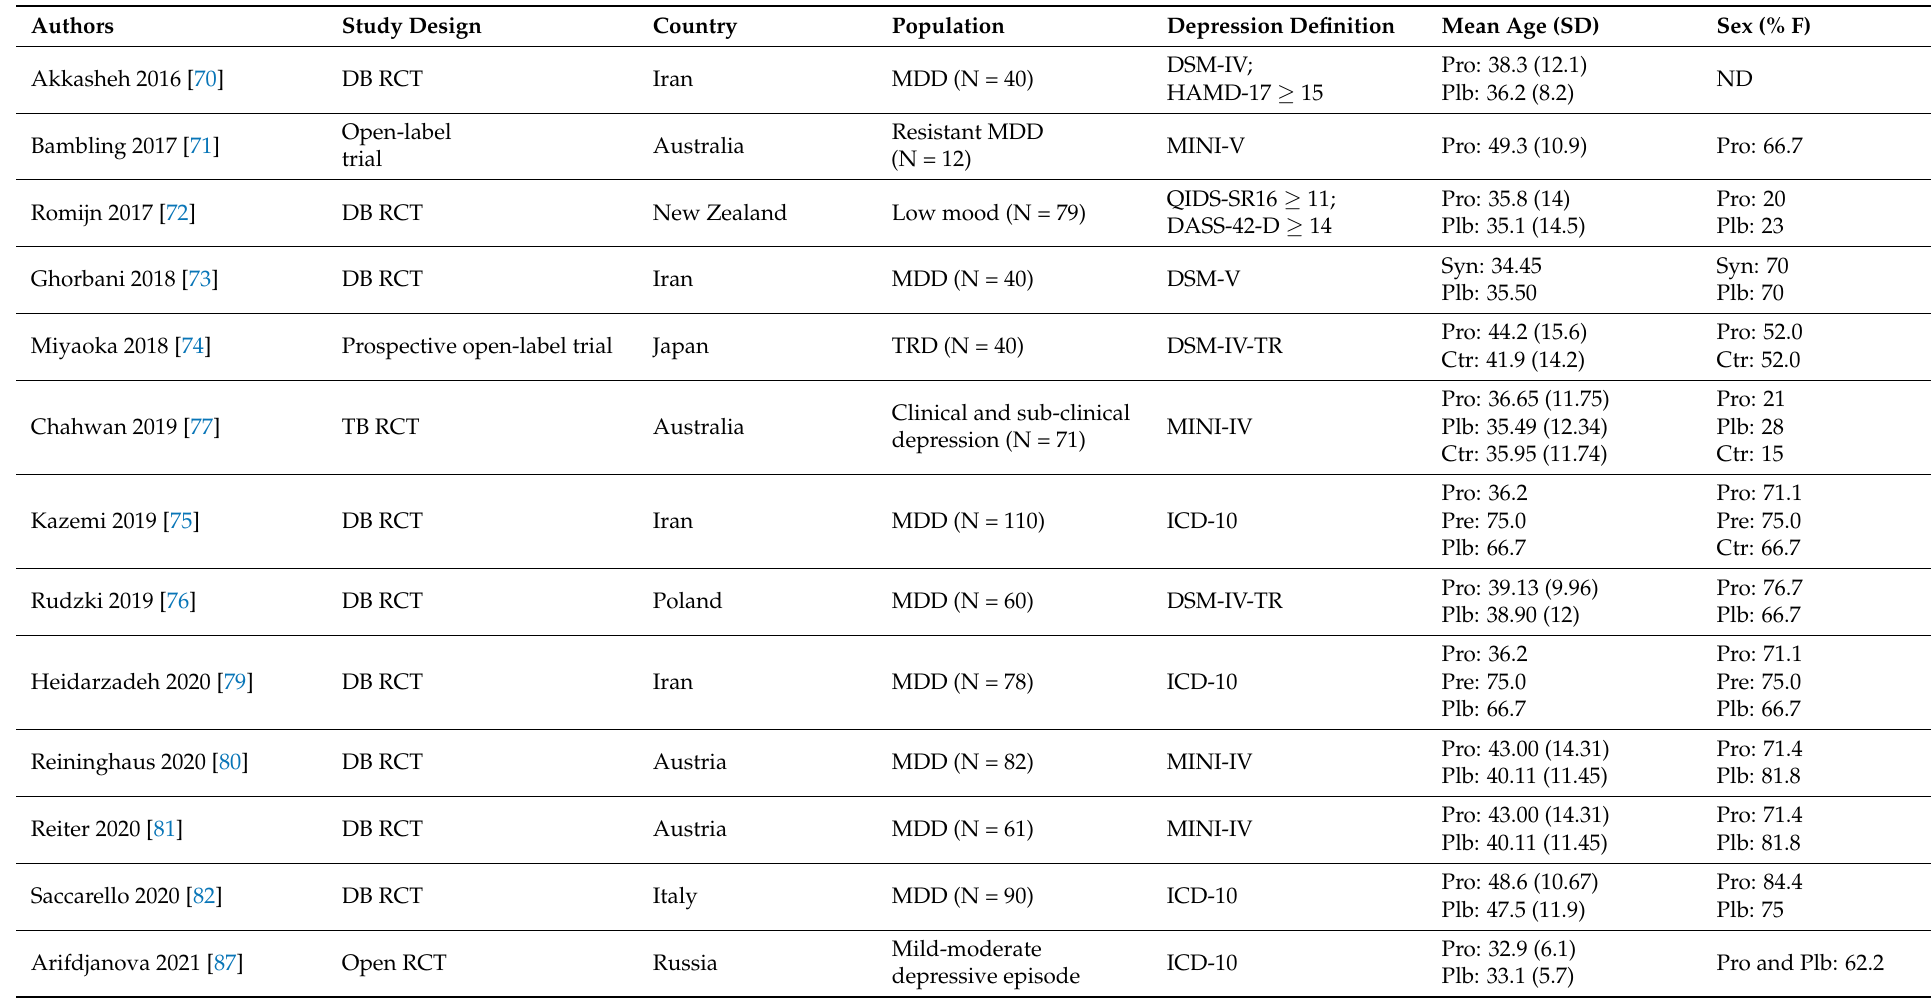
Table 4. Characteristics of the clinical trials on prebiotics, probiotics, and synbiotics in major depressive disorder included in the systematic